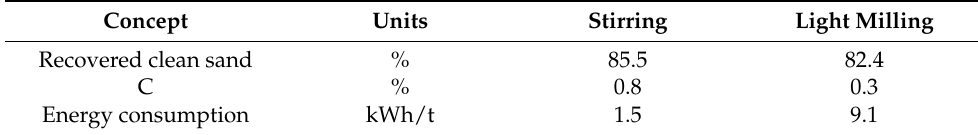
Table 4. Energy consumption for both attrition mechanism performed in this